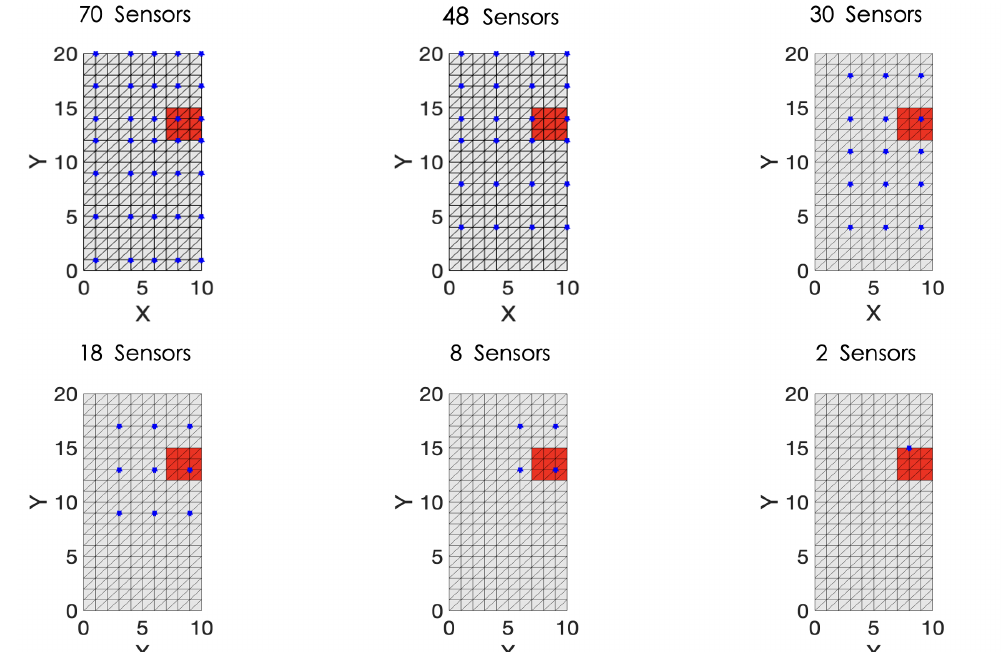
Figure 6. Top view of sensors location for different